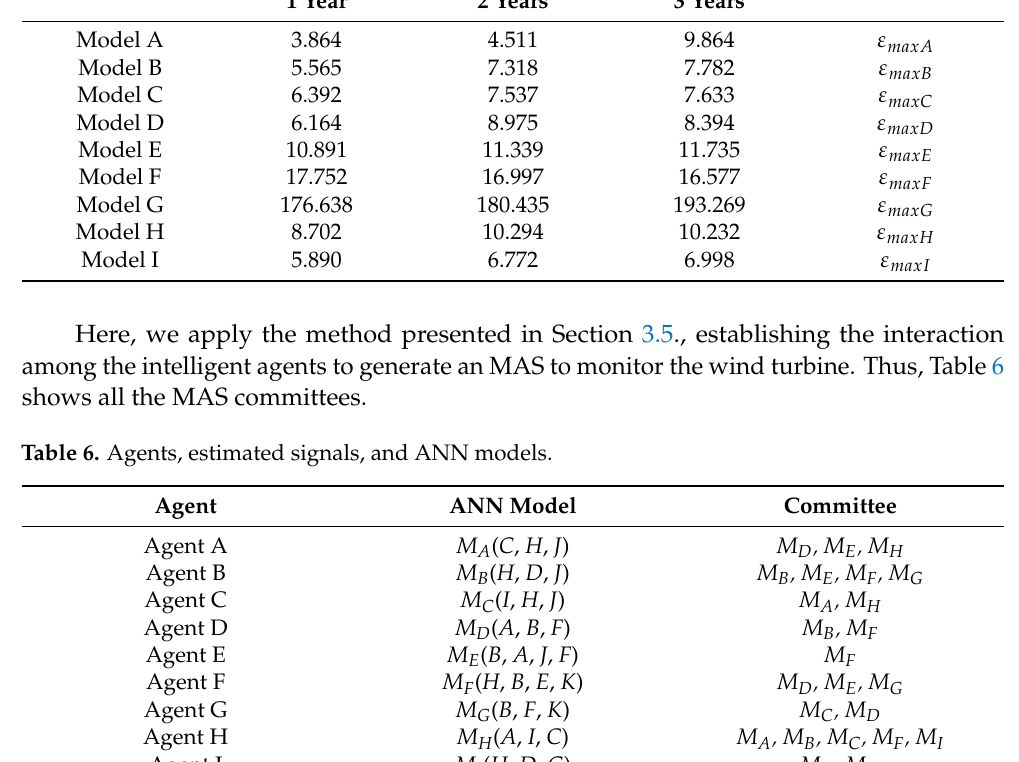
Table 5. Agent activation thresholds for one, two, and three years. Model